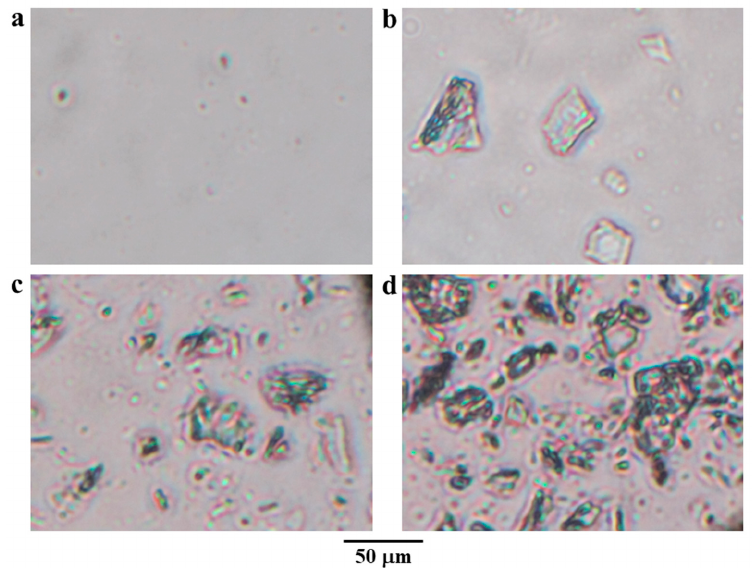
Figure 2. Microscopic morphology of QPM particles in QPM dispersion ( a ), and SA-QPM disper- sions at the ratios of 1:0.5 ( b ), 1:1 ( c ), and 1:2 ( d